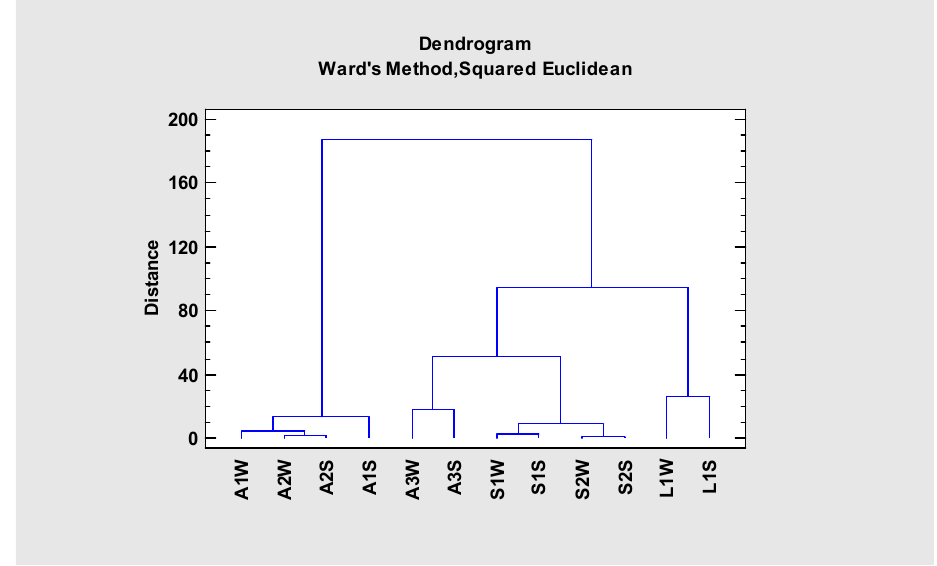
Figure 2. Dendrogram resulting from the cluster of the sampling sites using the Ward, Euclidean Square Method.